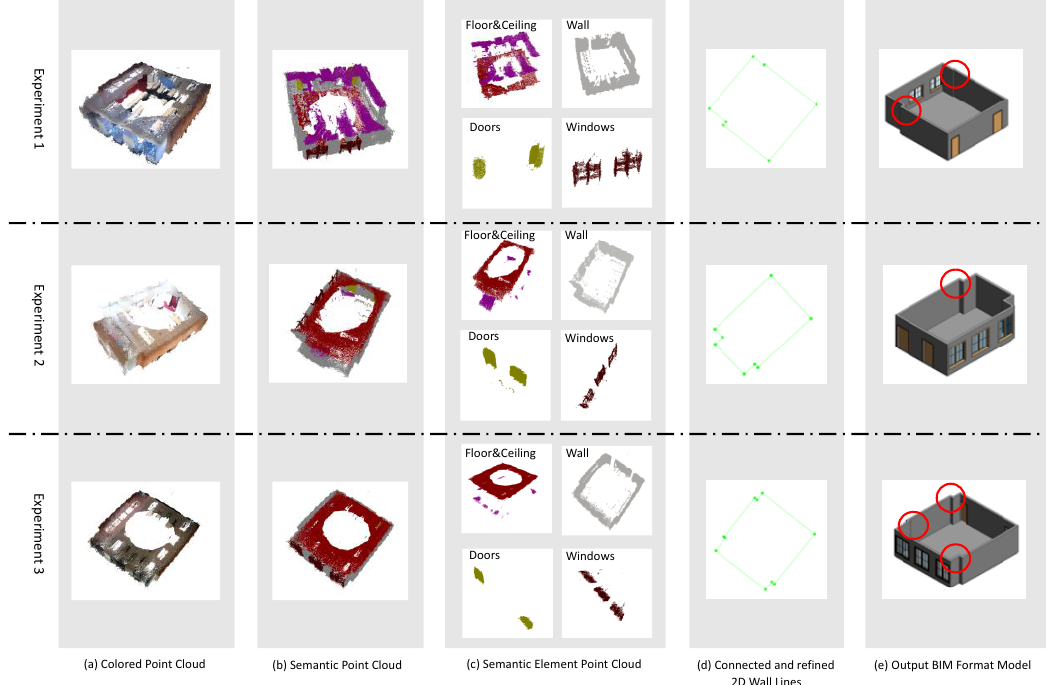
Figure 14. The detail processes from the raw point clouds to BIM format models.